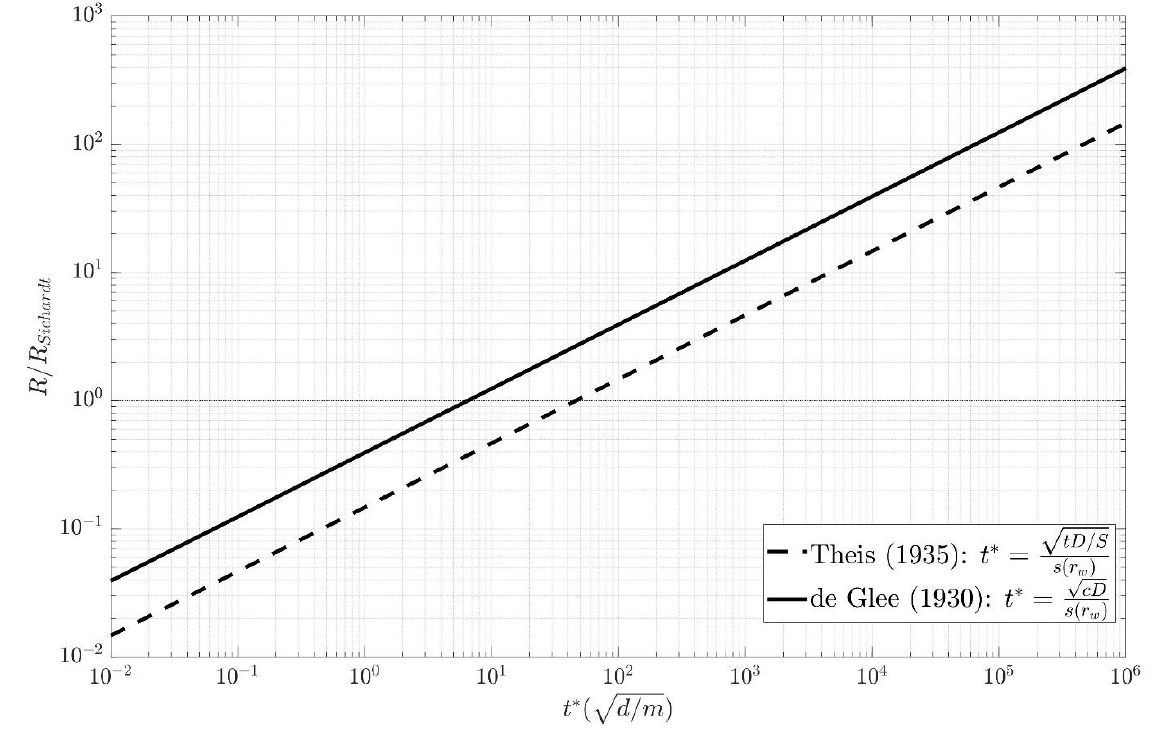
Figure 2. Plot showing the ratio of the radius of influence R approximated using the Theis or the de Glee equations and the radius of influence R Sichardt according to the empirical Sichardt formula as a function of parameter t* , which is defined in the figure’s legend. Parameter t is the time, D is the saturated thickness, S is the storage coefficient, c is the resistance, and s ( r w ) is the drawdown at the face of the well with radius r w . See text for definitions. The Sichardt radius of influence underestimates the hydraulic impact of the extraction if the ratio is larger than 1, i.e., above the horizontal dotted line. See text for a more detailed explanation.